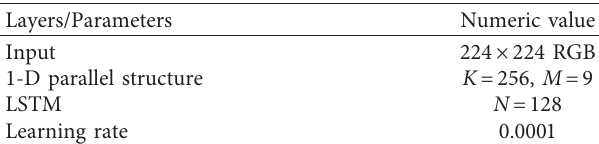
Table 2: The initial configuration of deep learning recognition